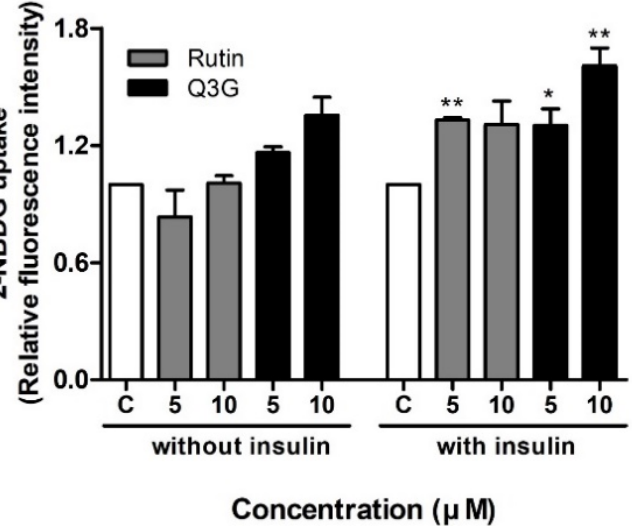
Figure 3. Effect of rutin and quercetin-3-O- β - D -glucoside (Q3G) on basal and insulin-stimulated (100 nM) 2-deoxy-2-((7-nitro-2,1,3-benzoxadiazol-4-yl)amino)- D -glucose (2-NBDG) uptake in differentiated 3T3-L1 adipocytes. Data are means ± standard error of the mean (SEM, n = 3); * p < 0.05 and ** p < 0.01 versus control. C, control.